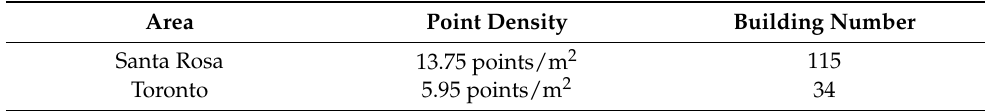
Table 1. Basic information of test dataset.